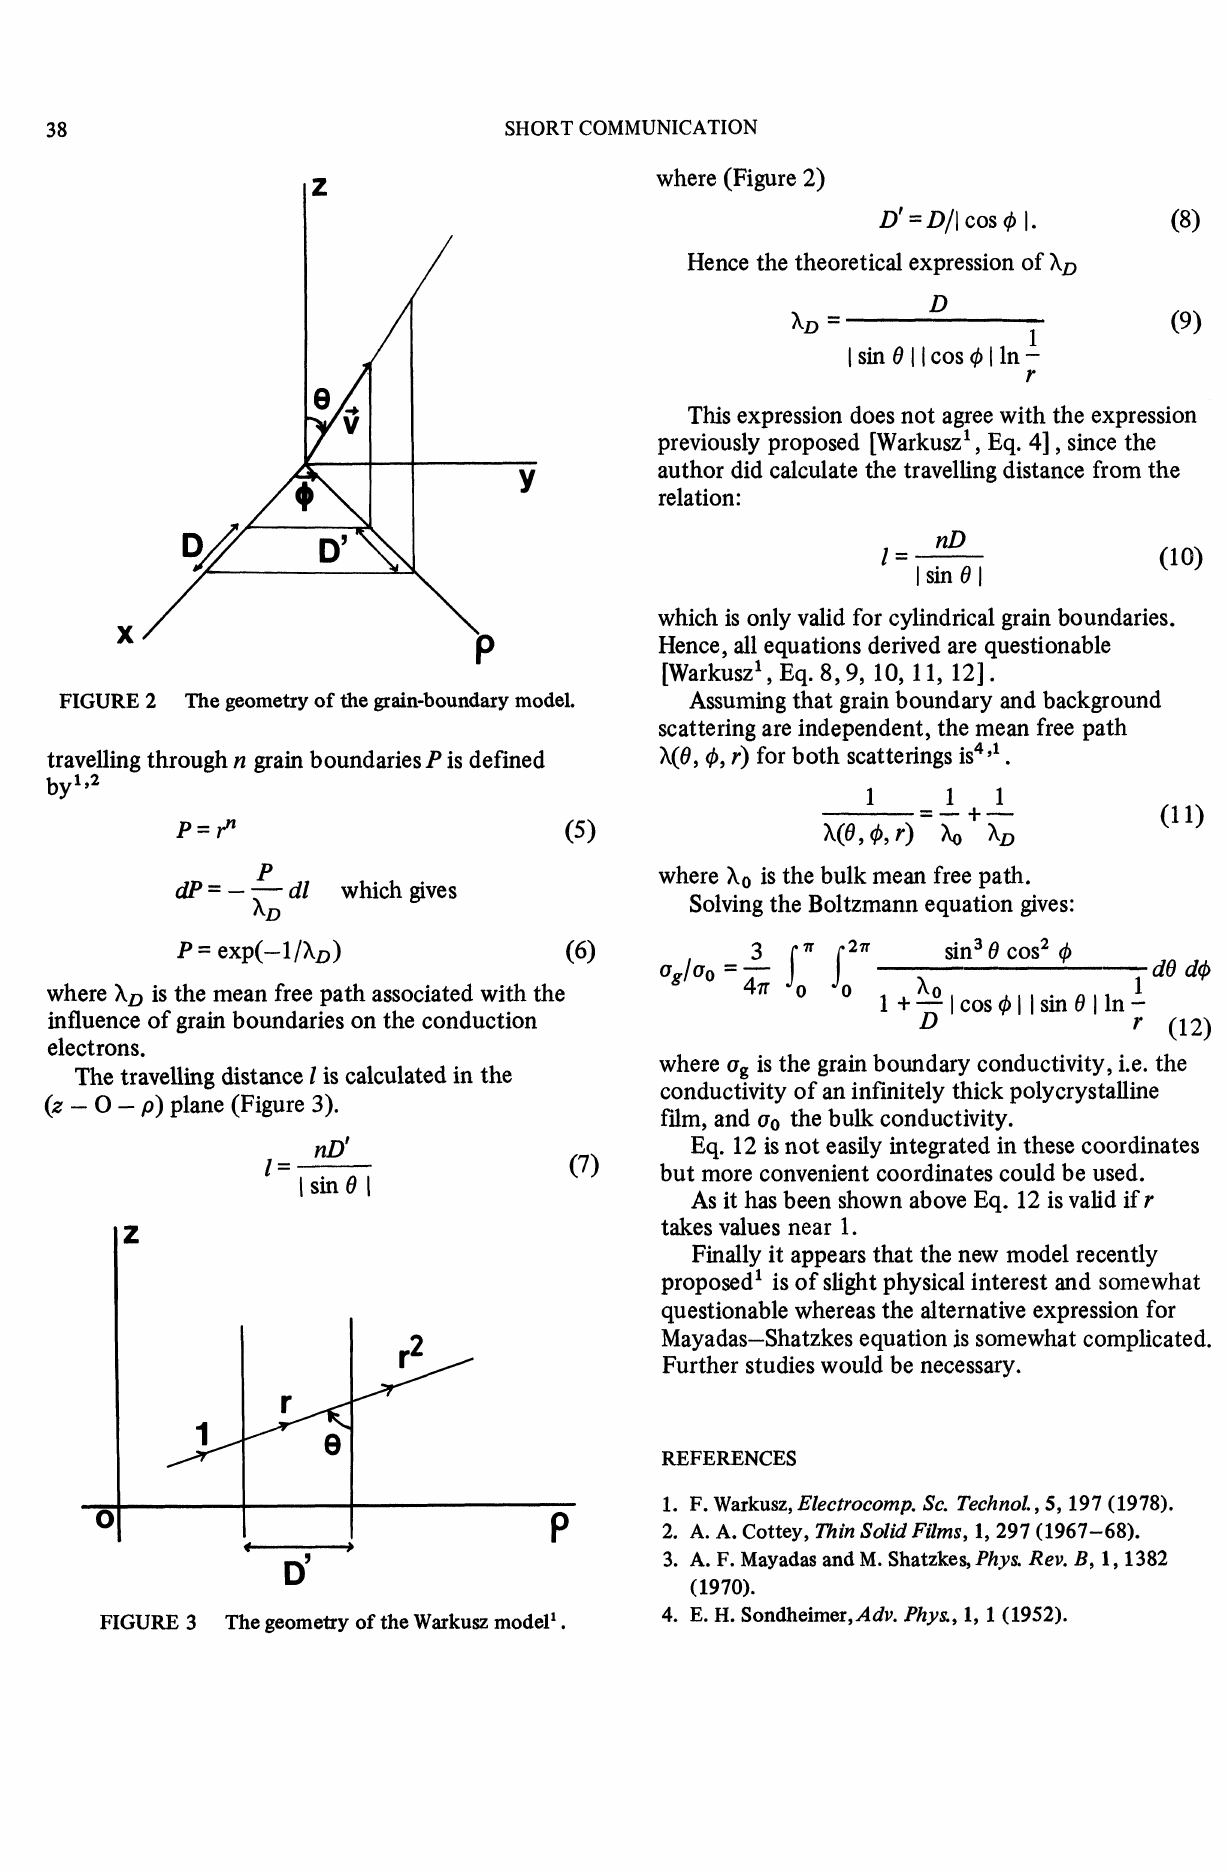
FIGURE 3 The geometry of the Warkusz